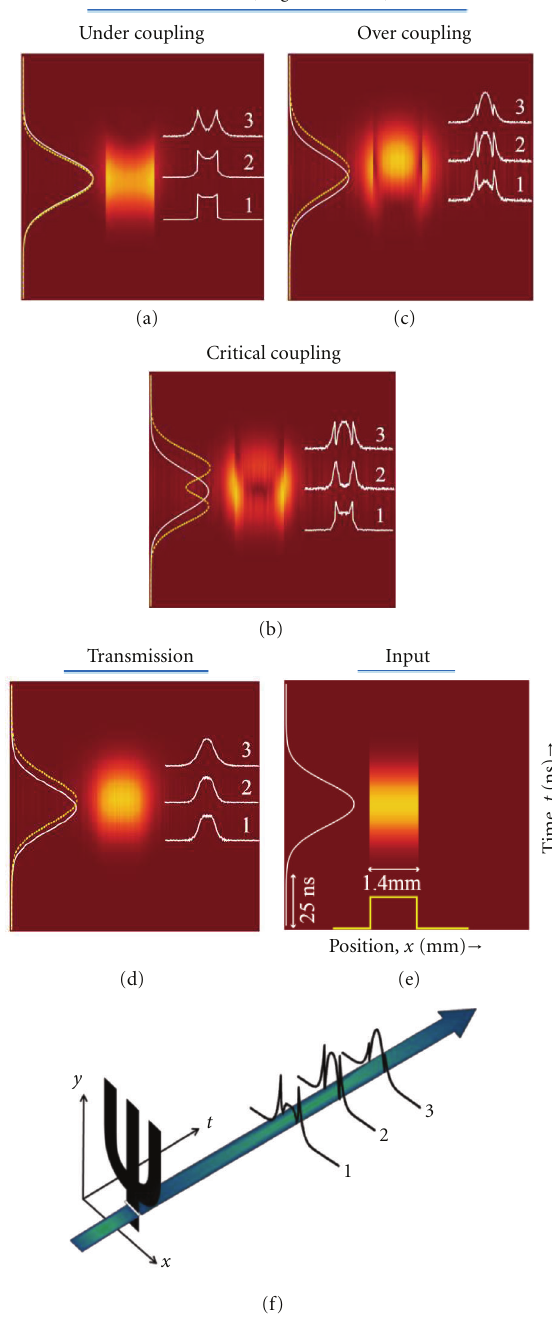
Figure 4: (a) − (d) Numerical simulation of the reflected and transmitted images in the space-time ( x - t ) domain for a single resonator. (a)–(c) Reflected images from the single resonator for under, critical, and over coupling conditions, respectively. (d) Transmitted image from the single resonator. (e) Input image of width 1.4mm (the horizontal axis) encoded on the temporal 25ns Gaussian pulse (the vertical axis). (f) Illustration of the cross- section of the 2D image that was considered for time evolution analysis. The earlier, intermediate, and later time profiles are indicated by the notations 1, 2, and 3, respectively, in Figures 4(a)–